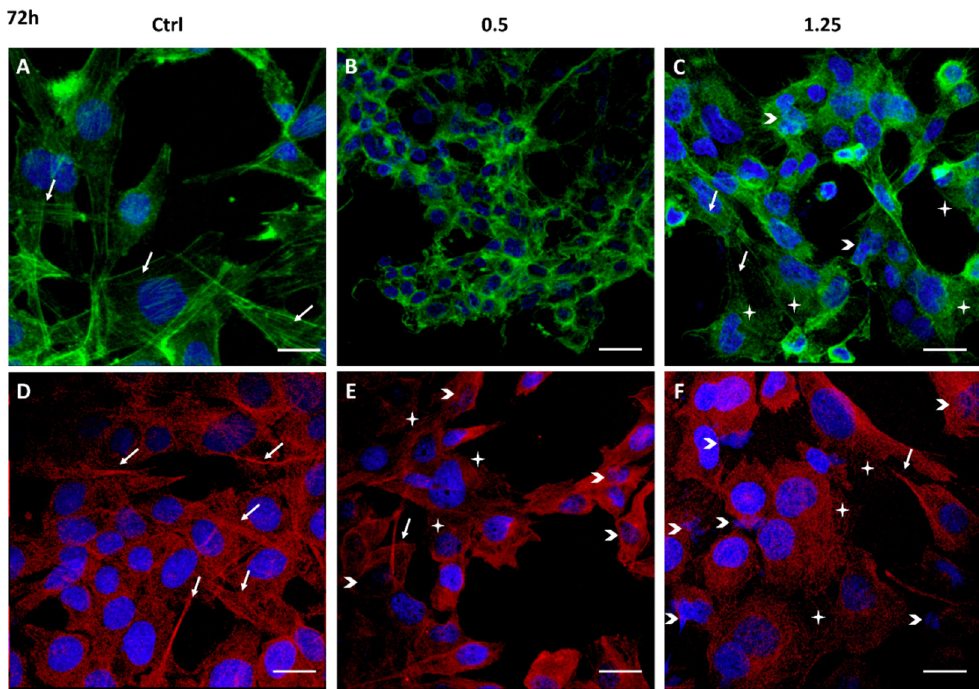
Figure 5. Cytoskeleton structure analysis of 1321N1 cells untreated ( A , D ) and treated with 0.5% ( B , E ) and 1.25% v / v ( C , F ) Rapha Myr ® extract for 72 h. Representative IF images for actin stained with FITC-Phalloidin (green; A , B , C ), microtubules stained with anti– α -tubulin antibody (red; D , E , F ) and nuclei with DAPI (blue); a merge was made. White arrows: stress fibers in green fluorescent images and bundles of microtubules in red fluorescent images; arrowheads: small or misshapen nuclei; stars: disorganized actin or microtubule network. Scale Bar: 20 µm.